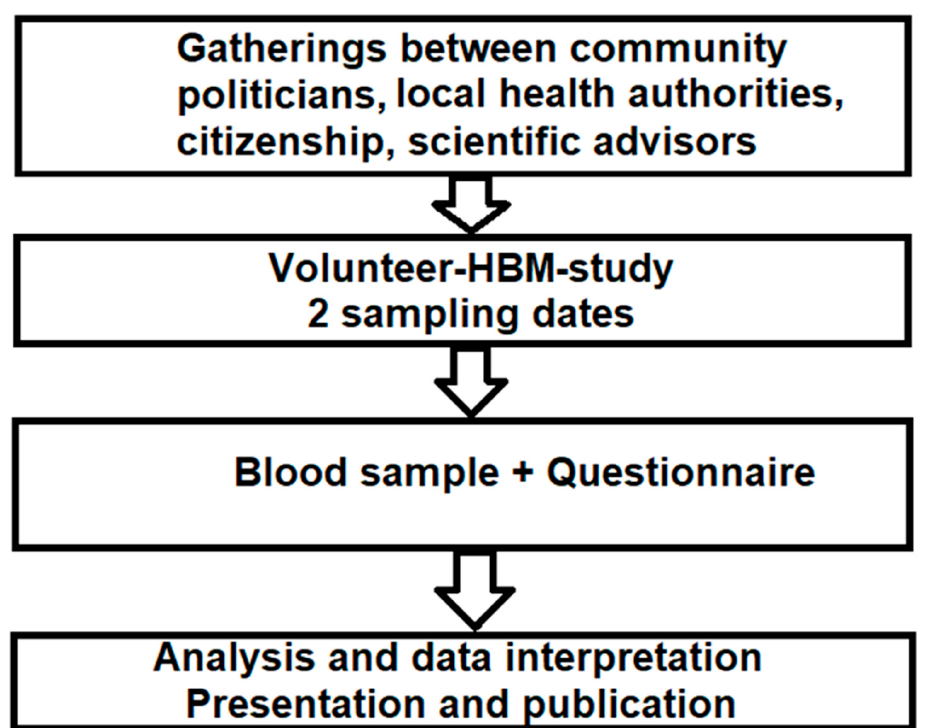
Figure 1. Conceptual framework of the Human Biomonitoring (HBM)-study conducted.